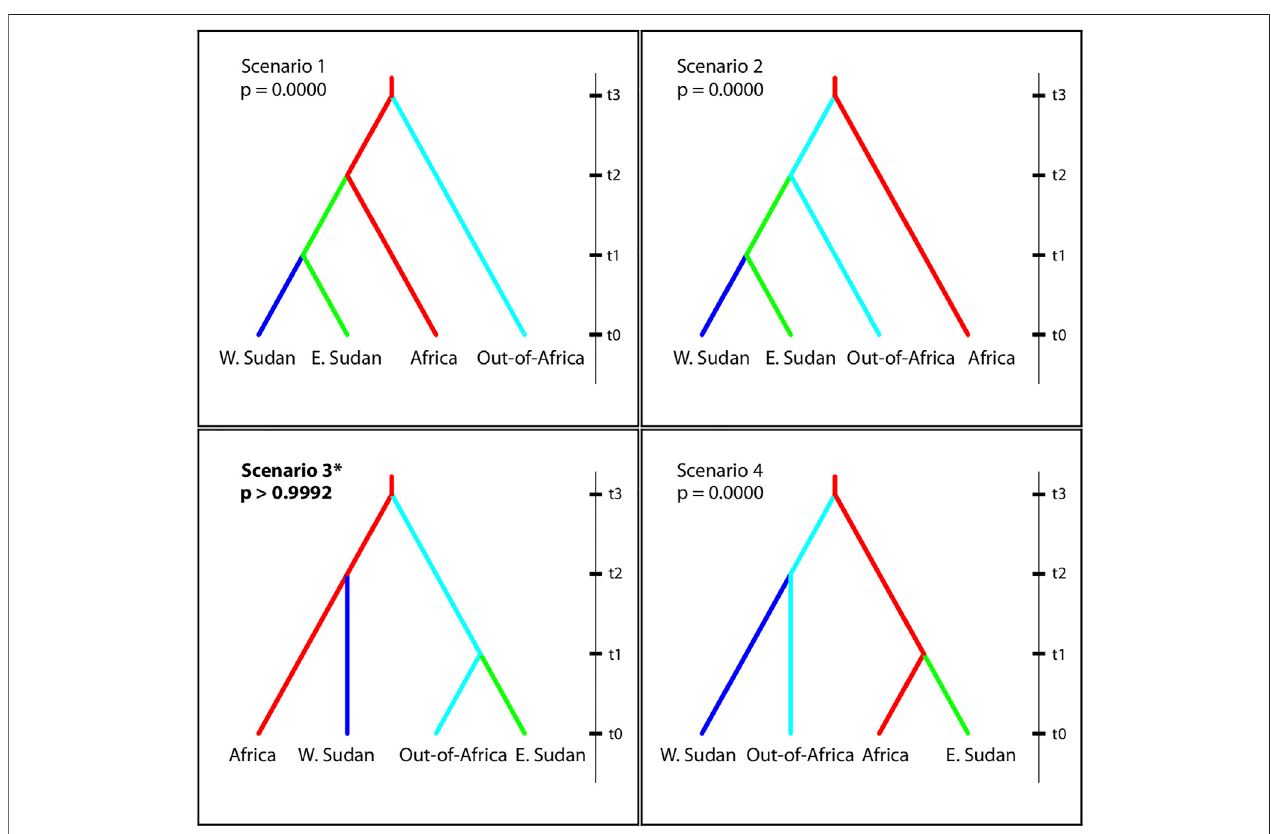
FIGURE 6 | Evolutionary scenarios of Ae. aegypti colonization of Sudan evaluated using Approximate Bayesian Computation inference, as implemented by the DIYABC software (Cornuet et al., 2014). Scenarios include four regions: Western Sudan, Eastern Sudan, Africa, out-of-Africa, N = 30 randomly chosen individuals for each region. t0representsthemost recenttime, point. Increasingvalues oftarenot toscaleand are notnecessarilybe inchronological order. Posterior probabilities are shown for each scenario. For more details see Materials and Methods and Supplementary Table S3.